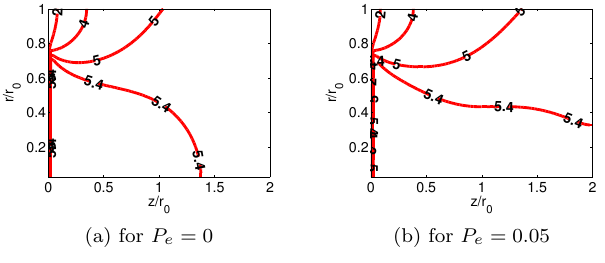
Figure 3. Temperature levels.